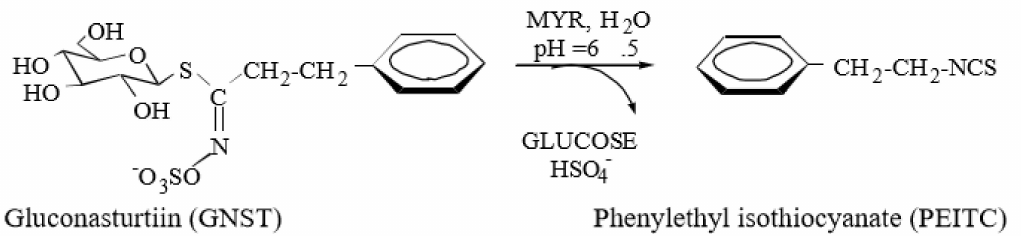
Figure 1. Hydrolysis of gluconasturtiin to phenethyl-isothiocyanate (PEITC) catalyzed by myrosinase at neutral pH. Adapted from Barba et al.